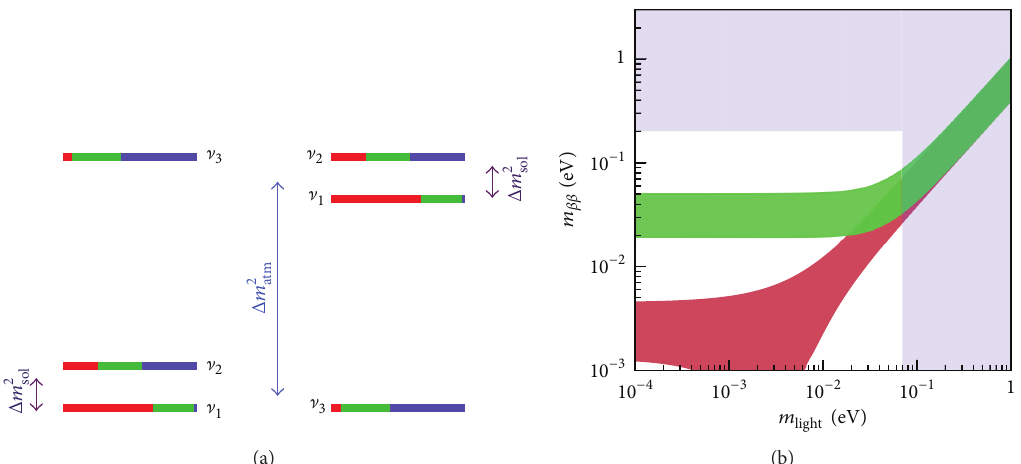
Figure 2: The left image shows the normal (a) and inverted (b) mass orderings. The electron, muon, and tau flavor content of each neutrino mass eigenstate are shown via the red, green, and blue fractions, respectively. Δ𝑚 2 ≡ 𝑚 2 − 𝑚 2 and Δ𝑚 2 3 2 in the inverted ordering. The right plot shows the effective neutrino Majorana mass, atm . The green band corresponds to the inverse hierarchy of neutrino masses, whereas the red corresponds to the normal neutrino mass, 𝑚 light ordering. The upper bound on the lightest neutrino mass comes from cosmological bounds; the bound on the effective Majorana mass comes from 𝛽𝛽0 ]